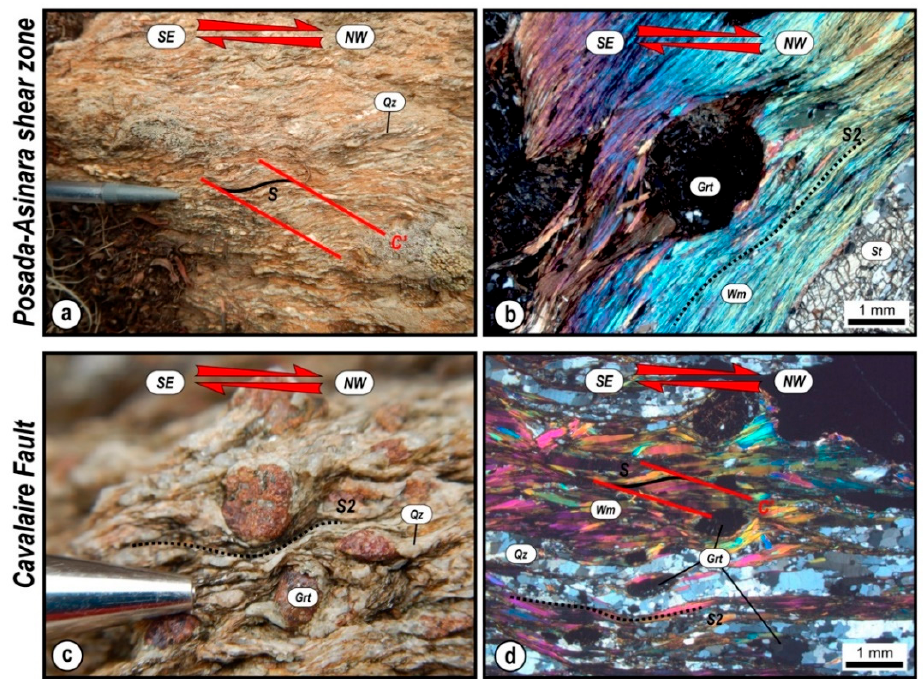
Figure 6. Evidence of shear deformation at the meso- and microscale of the PASZ and CF: ( a ) S-C ′ fabric pointing to a top-to-the-NW sense of shear in the garnet-bearing micaschist; D2 transpressional deformation phase (coord. Lat 40°34 ′ 49.96 ″ N—Long. 9°15 ′ 37.30 ″ E) from the PASZ. ( b ) Asymmetric strain fringes around a garnet porphyroclast showing a top-to-the-NW sense of shear in staurolite-garnet-bearing micaschist (CPL) (coord. Lat 40°33 ′ 04.52 ″ N—Long. 9°24 ′ 38.00 ″ E) from the PASZ. ( c ) Asymmetric quartz strain fringes around a garnet porphyroclast in garnet-bearing micaschist showing a top-to-the-NW sense of shear; D2 transpressional deformation phase (coord. Lat 43°11 ′ 11.42 ″ N—Long. 6°35 ′ 11.22 ″ E) from the CF. ( d ) S-C ′ fabric pointing a top-to-the-NW sense of shear in garnet-bearing micaschist (CPL) (coord. Lat 2°11 ′ 11.20 ″ N—Long. 6°35 ′ 11.50 ″ E) from the CF. Mineral abbreviations as in Whitney and Evans (2010) [38].